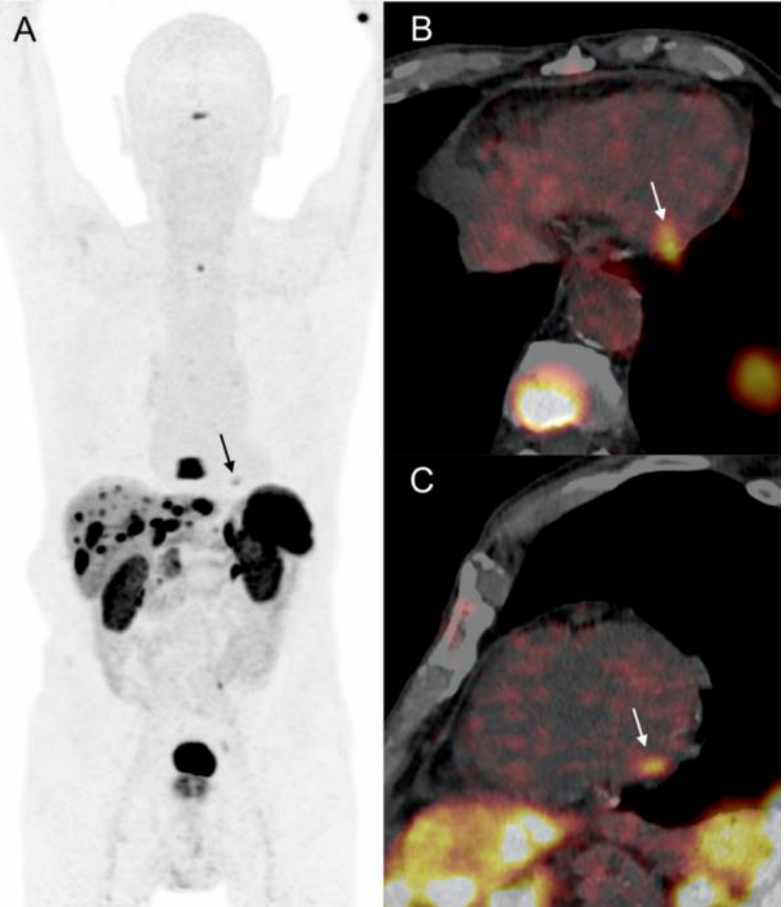
Figure 5. Patient 3. 75-year-old patient with metastatic si-NET and LV CM (arrow). Cardiac lesion showed pathological uptake of 68 Ga-DOTATOC (( A ) MIP anterior projection, ( B ) PET/CT horizontal long axis, ( C ) PET/CT short axis).